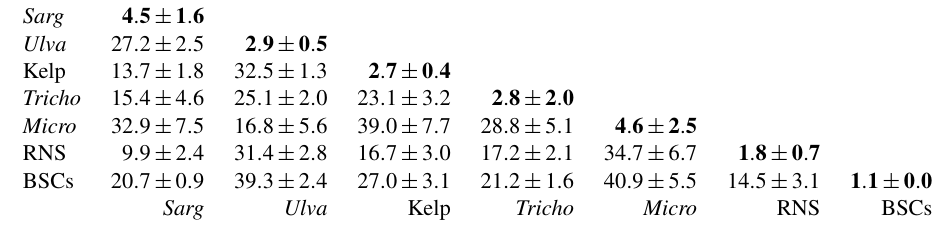
Table 1. Spectral angle mapper values (degrees) between different floating matters for the spectral range of 450–670nm, derived from the HICO-derived and field-measured spectra shown in Figs. 2–4. An SAM of 0 ◦ indicates an identical spectral shape, while an SAM of 90 ◦ indicates a completely different spectral shape. Sarg : Sargassum fluitans and S. natans ; Ulva : Ulva prolifera ; Tricho : Trichodesmium ; Micro : Microcystis ; RNS: red Noctiluca scintillans ; BSCs: brine shrimp cysts. Because all floating algae show similar red-edge reflectance with a reflectance trough around 670nm, the exclusion of wavelengths of > 670nm is to reduce the similarity among different types of floating algae. Bold font indicates strong similarity (SAM < 5 ◦